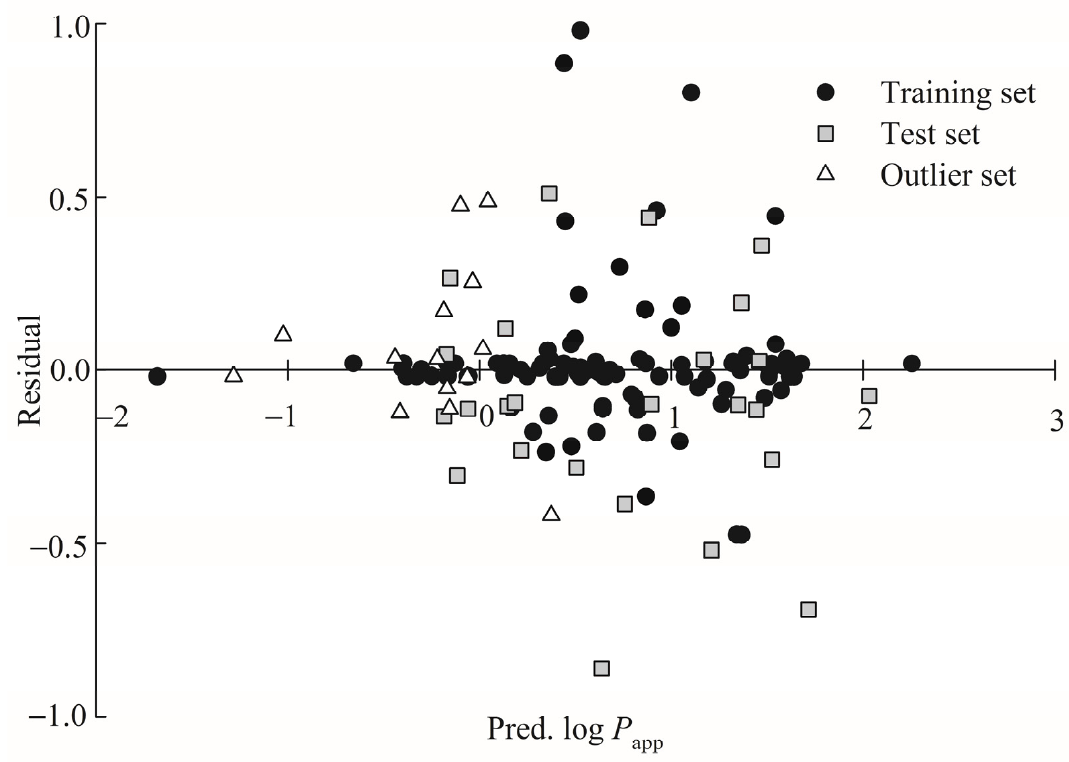
Figure 5. Residual versus the log P app prediction by HSVR in the training set (solid circle), test set (gray square), and outlier set (open triangle).